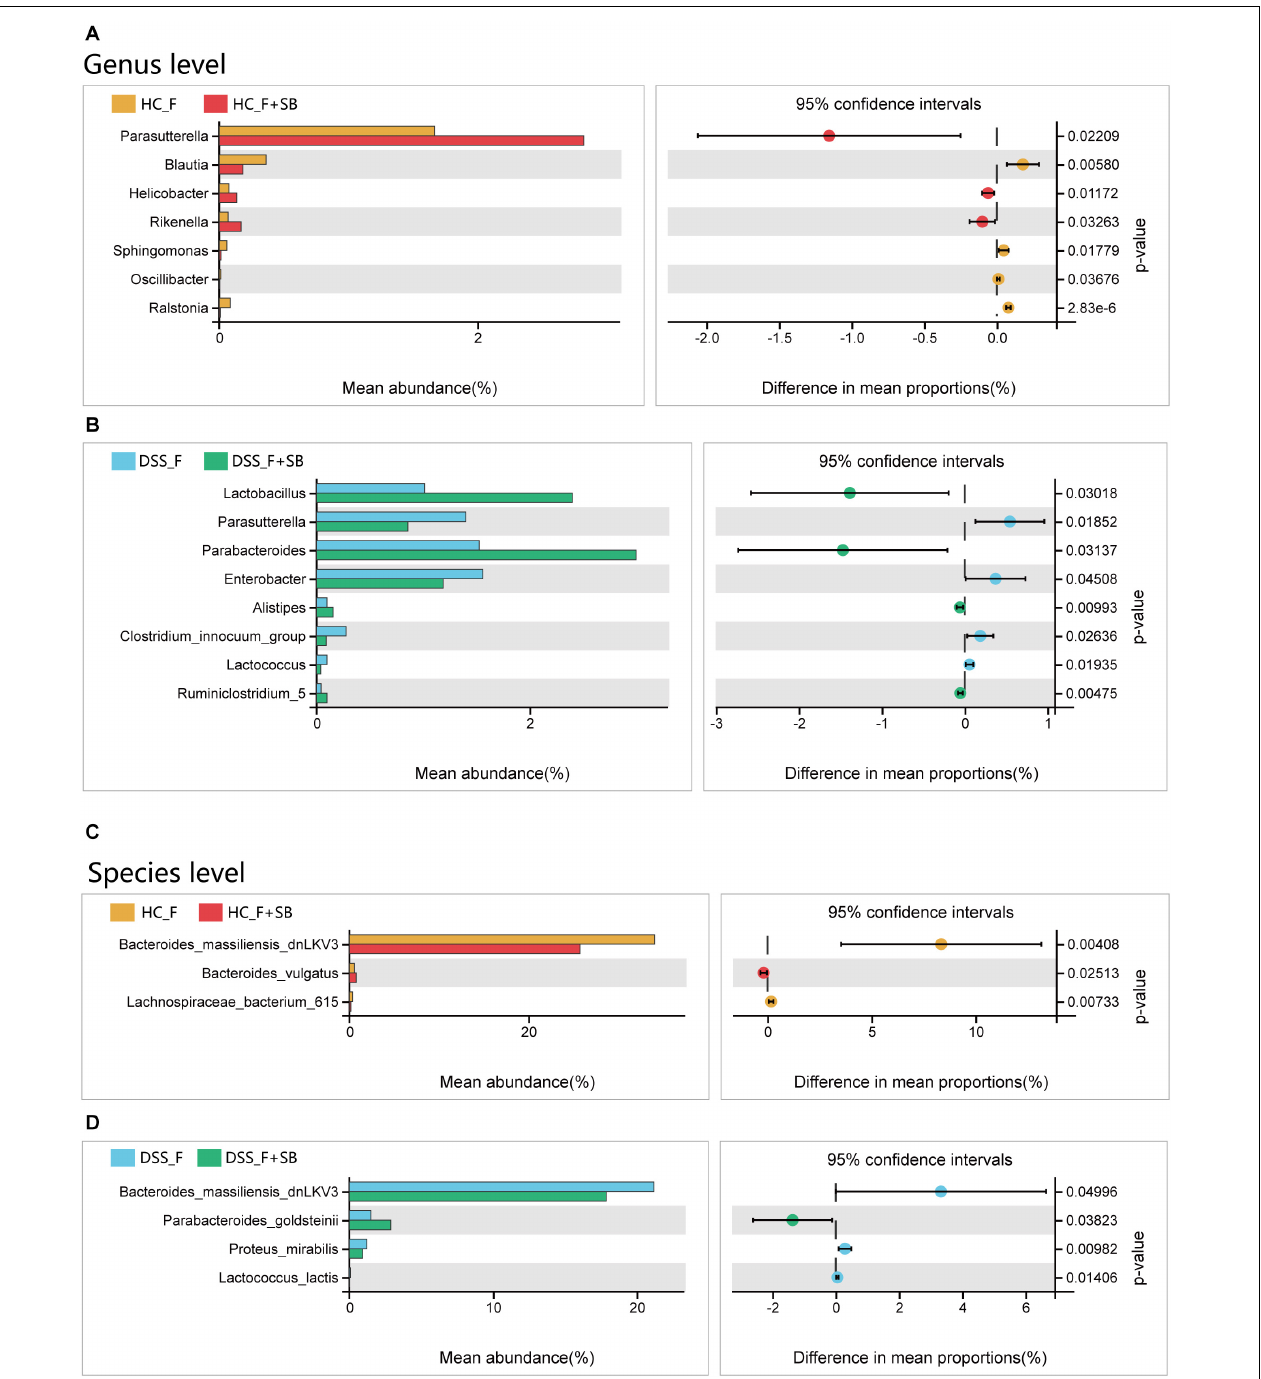
FIGURE 7 | Butyrate modulates the structure of fecal microbiota in vitro . (A,B) Butyrate alters the structure of fecal microbiota from healthy control mice at the genus and species levels, respectively. (C,D) Butyrate changes the structure of fecal microbiota from colitis mice at the genus and species levels, respectively.